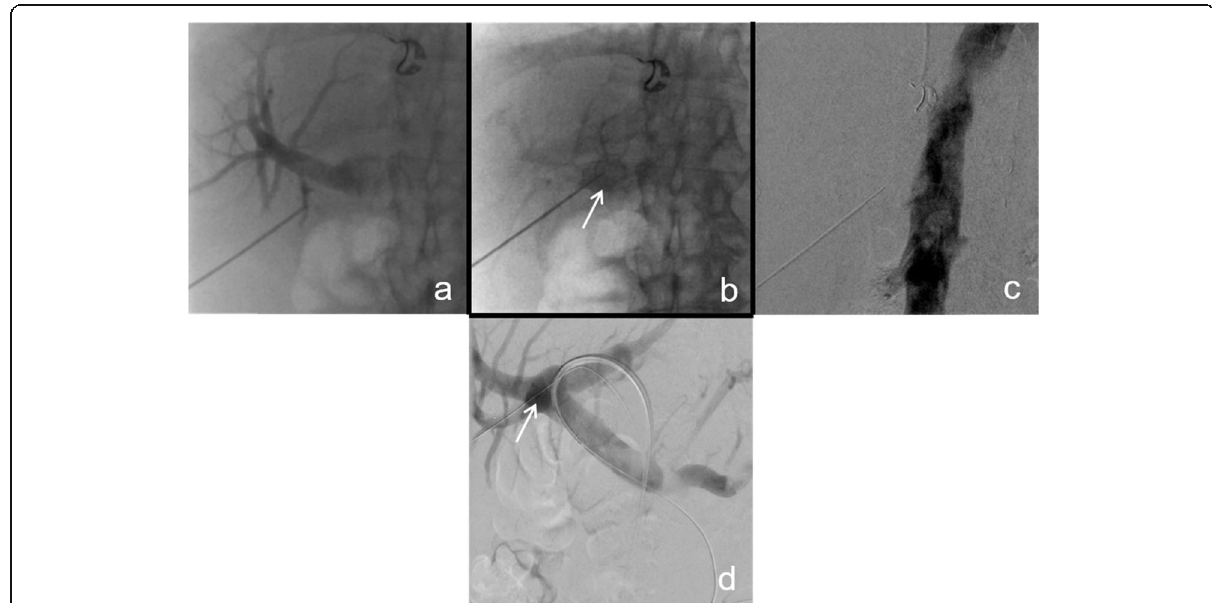
Fig. 1 Fluoroscopic images of the percutaneous puncture of the main trunk of the right portal vein and the IVC. A In this case, initially a small branch of the portal vein was punctured as is seen in fluoroscopy. This was not a suitable vessel for DIPS creation. B The tip of the needle is in the main trunk of the right portal vein (white arrow image B and D ), this is confirmed by angiogram. C The needle is further advanced into the IVC and correct positioning is confirmed in angiography. D Note the in place “ buddy-wire ” entering the right trunk of the portal vein via the initial puncture site (white arrow, image B